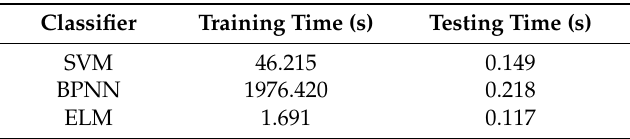
Table 7. Comparison of computing time of different classifiers.